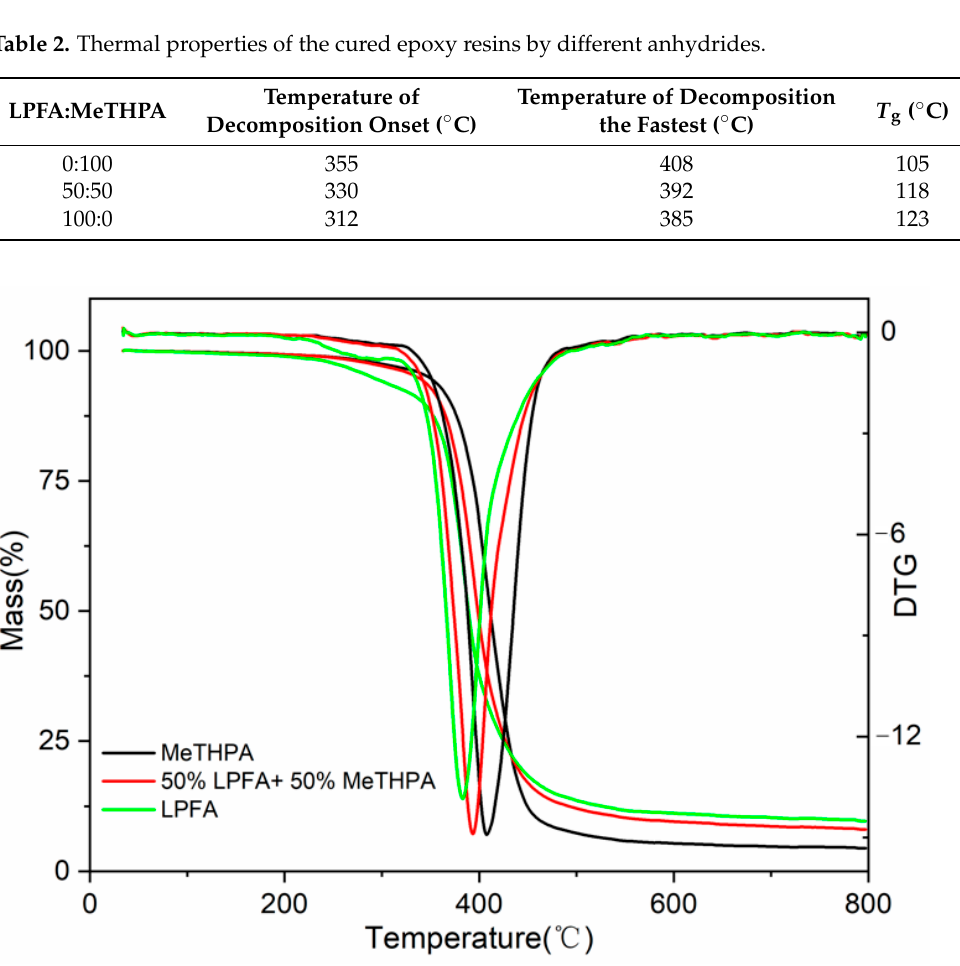
Figure 5. Thermogravimetric curves of the LPFA- and MeTHPA-cured epoxy resins.